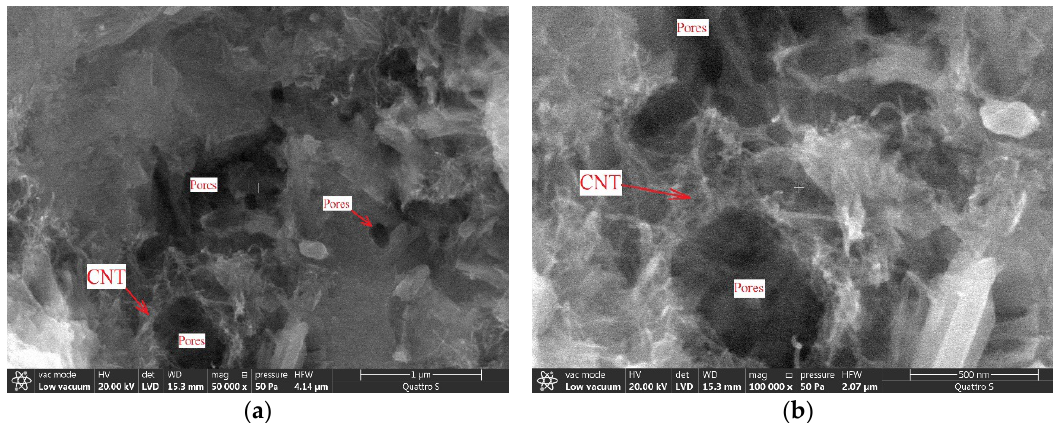
Figure 9. Pores formed with nanotube conglomerates: ( a ) -at 50,000-fold magnification, ( b ) -at 100,000-fold magnification.